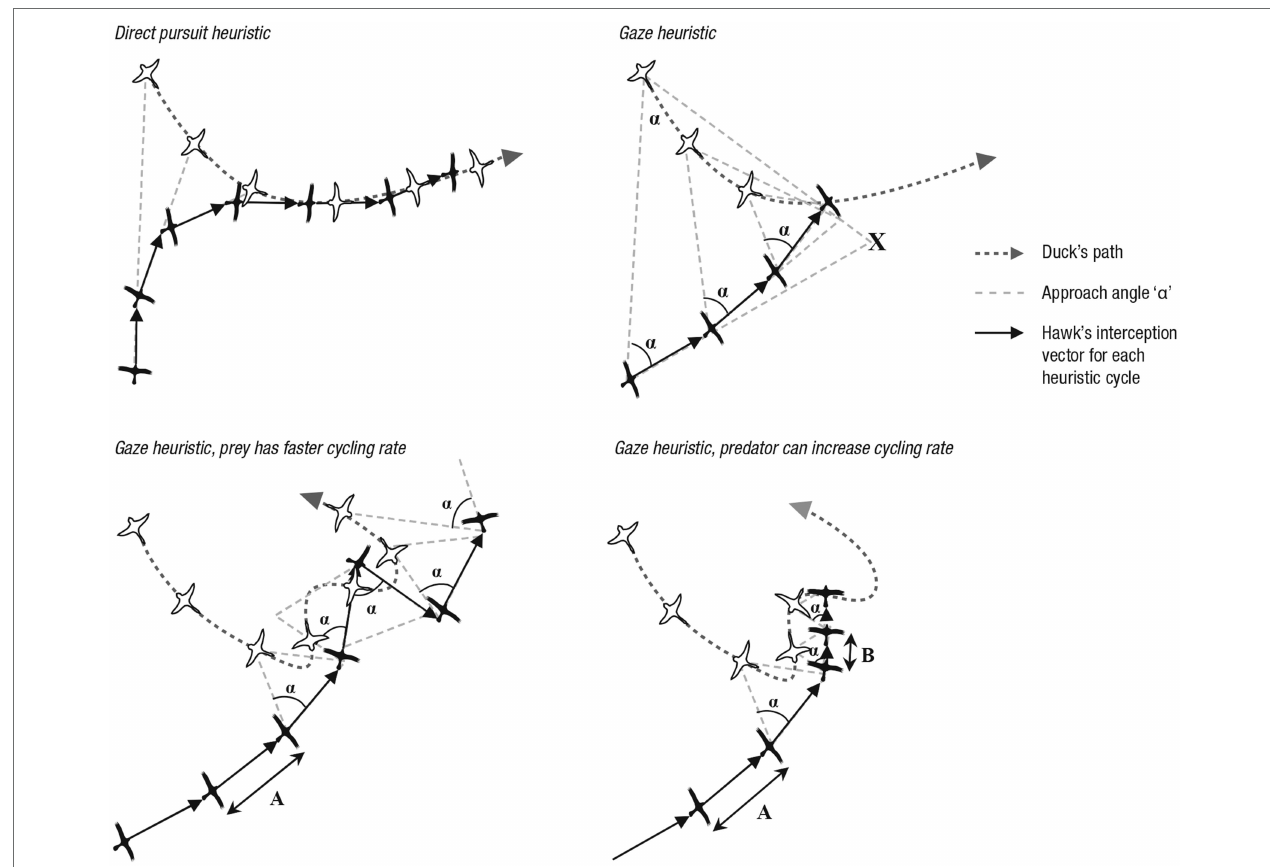
FIGURE 3 | Predators (dark hawks) pursuing prey (white ducks). From top left to bottom right: Direct pursuit heuristic: A predator flies in the direction that is the shortest path to the prey, and adjusts the direction when the prey changes its course. If predator and prey fly at the same speed, the result is a characteristic wavering pursuit pattern. Gaze heuristic: A predator determines the angle α between the direct line to the prey and the initial estimate X of the intersection point, and then adjusts its direction to the subsequent flight path of the duck so that α remains constant. Even when both predator and prey fly at the same speed, the predator can intercept the prey. Predator relies on gaze heuristic, but prey has faster cycling rate : The number of adjustments an animal can make per second is its cycling rate, represented by the length A of its path before it can change its direction. Here, the prey has a faster cycling rate than the predator, which enables it to evade the predator. Predator relies on gaze heuristic and can increase cycling rate : Here, the predator has the ability to increase the cycling rate from A to B , which is higher than that of the prey, resulting in fast interception. Adapted from Hamlin